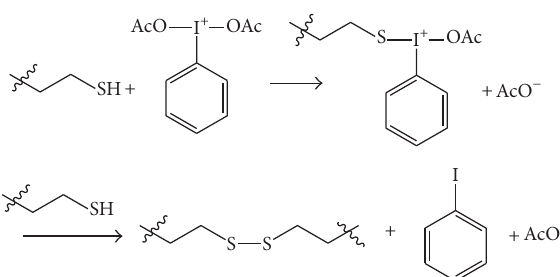
Scheme 2: Mechanism of the oxidation of thiols using